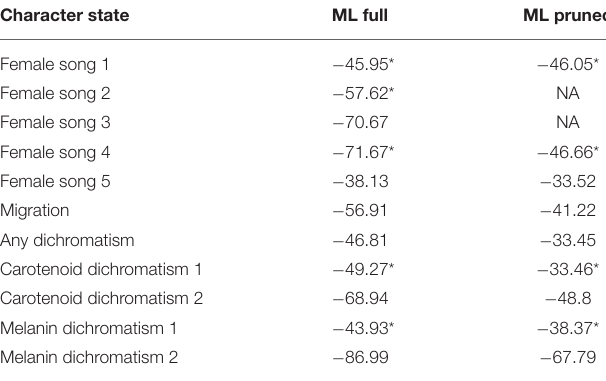
TABLE 2 | Character state